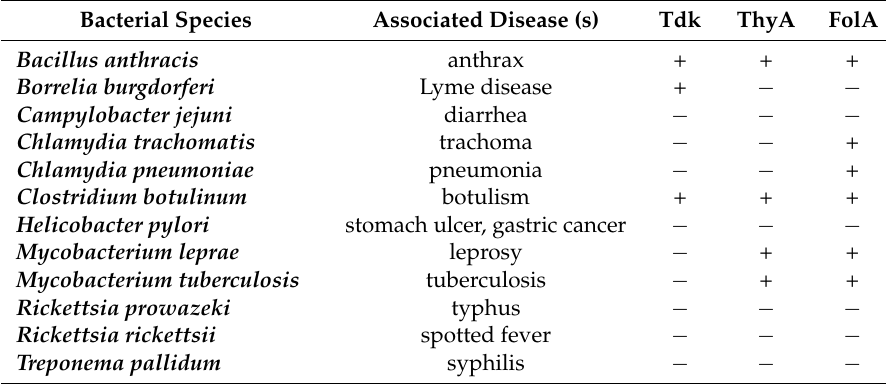
Table 1. Table of pathogenic bacterial species containing ThyX as well as whether thymidine kinase (Tdk) and TSase (ThyA) or DHFR (FolA) are present [16,17]. Bacterial Species Associated Disease (s) Tdk ThyA FolA Bacillus anthracis anthrax + + + Borrelia burgdorferi Lyme disease + − − Campylobacter jejuni diarrhea − − − Chlamydia trachomatis trachoma − − + Chlamydia pneumoniae pneumonia − − + Clostridium botulinum botulism + + + Helicobacter pylori stomach ulcer, gastric cancer − − − Mycobacterium leprae leprosy − + + Mycobacterium tuberculosis tuberculosis − + + Rickettsia prowazeki typhus − − − Rickettsia rickettsii spotted fever − − − Treponema pallidum syphilis − − −